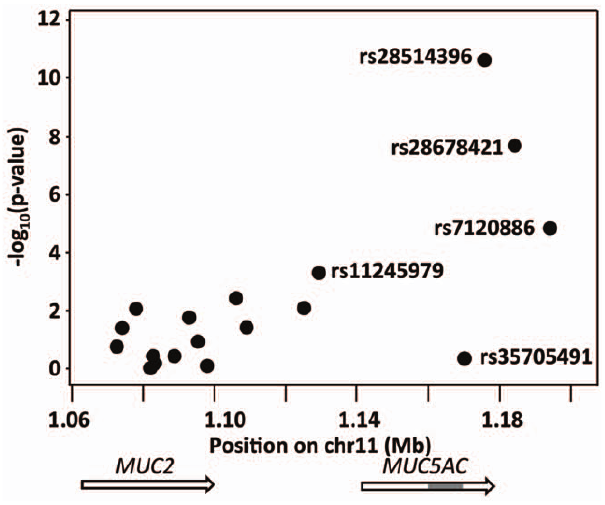
Figure 4. Analysis of differential linkage disequilibrium between MUC5AC 6.3 and 6.4 kb alleles versus nearby SNPs. P values represent evidence of an improved fit to the LD patterns between SNPs and the VNTR when 6.3/6.4 are treated as separate VNTR alleles (three-allele system) instead of being collapsed into a single allele (two-allele system). The p values represent a direct test of the hypothesis that the 6.3 kb and 6.4 kb alleles follow distinct LD patterns with the surrounding SNPs. Non-significant p values, e.g., those 5 9 to MUC5AC , indicate that the two alleles share the same LD structure with the SNPs, while significant p values indicate that the LD pattern between the two alleles is different, e.g., at rs28514396. Approximate location of Hinf I fragment in MUC5AC shown in gray.